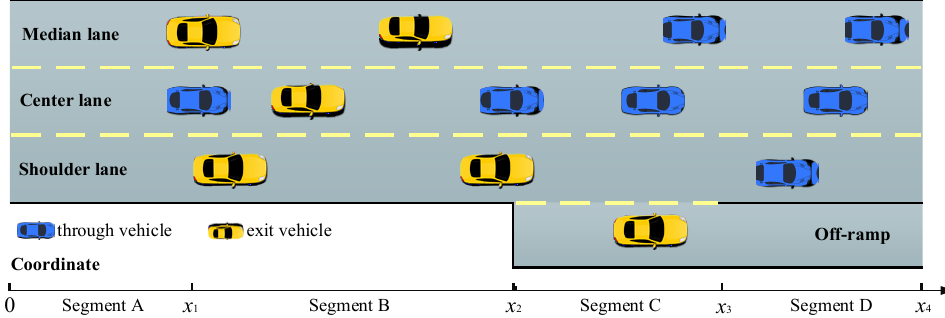
Figure 6. Coordinate system and frame of simulation freeway with an off-ramp.